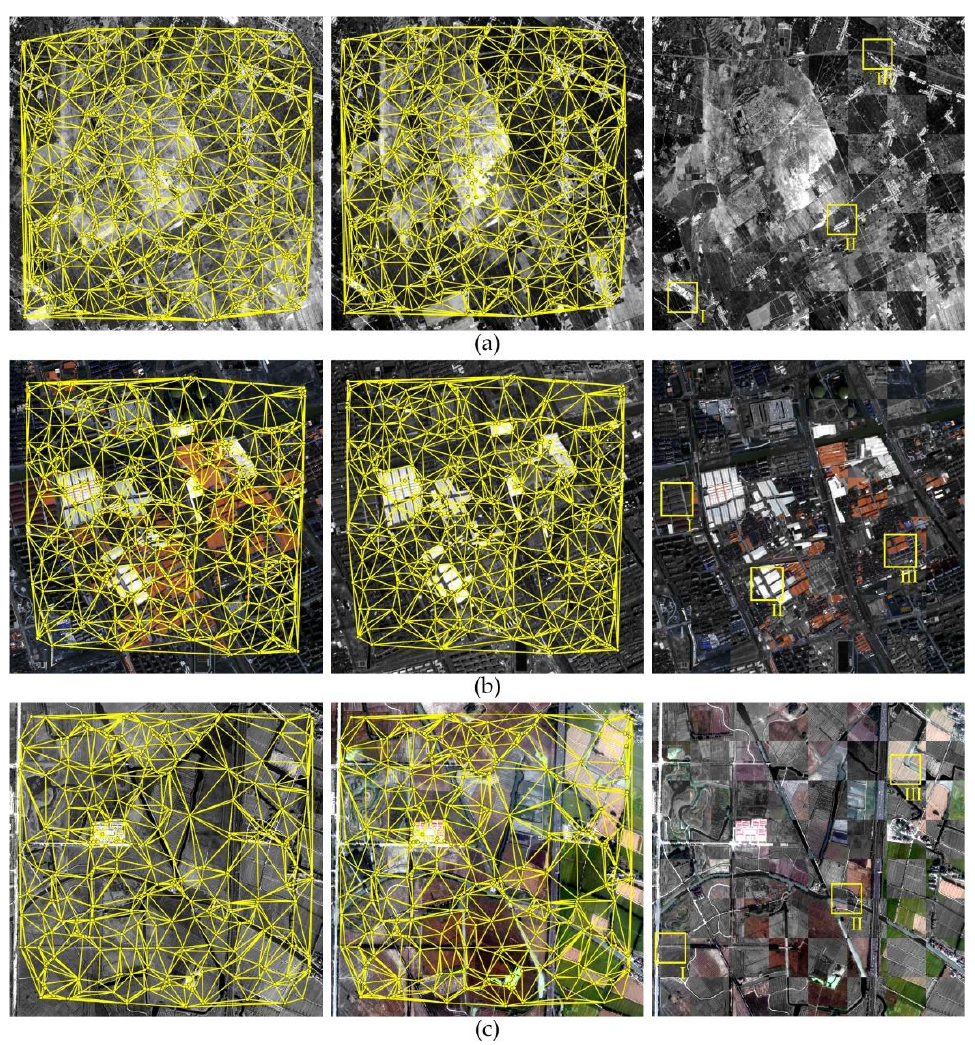
Figure 7. Registration results of the presented method for three test image pair. ( a ) Data 1; ( b ) Data 2; and ( c ) Data 3.